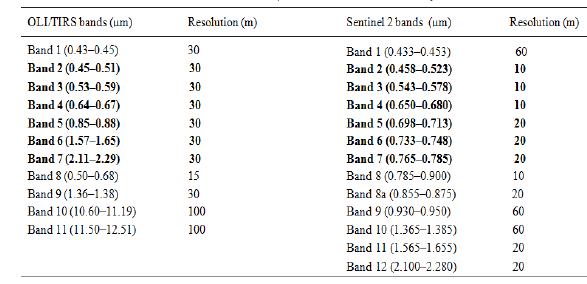
Table 1: Landsat OLI/TIRS, and Sentinel 2 spectral bands.